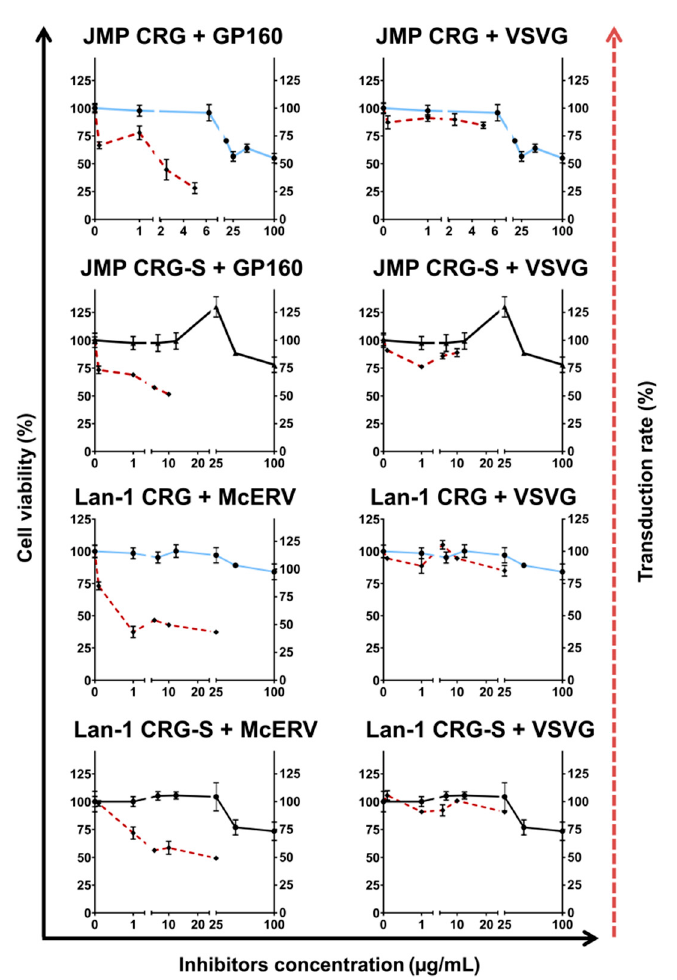
Figure 8. The antiviral action of κ / β -CRG compared to its cytotoxic activity. The solid lines represent the percentage of viable cells Jurkat JMP or Lan-1 (left Y -axis) treated with CRGs ( κ / β -CRG or Car-S) in concentration range starting from 0.01 and up to 100 μ g/mL ( X -axis). The amount of living cells treated with CRGs was calculated and represented as a percentage to untreated cells. The dotted lines represent the percentage of transduced cells (right dotted transduction rate Y -axis) when RDLVs containing medium was added.